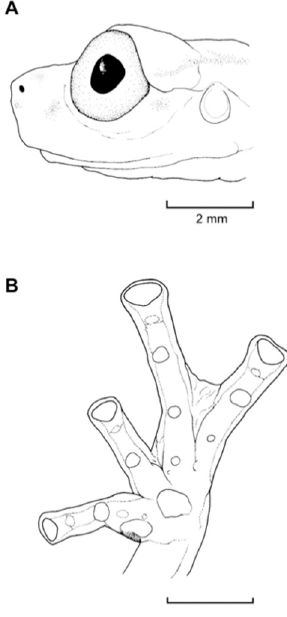
Figure 132. Nymphargus balionotus , adult male, KU 164708. ( A ) Head in lateral view. ( B ) Hand in ventral view. Illustrations Juan M. Guayasamin.